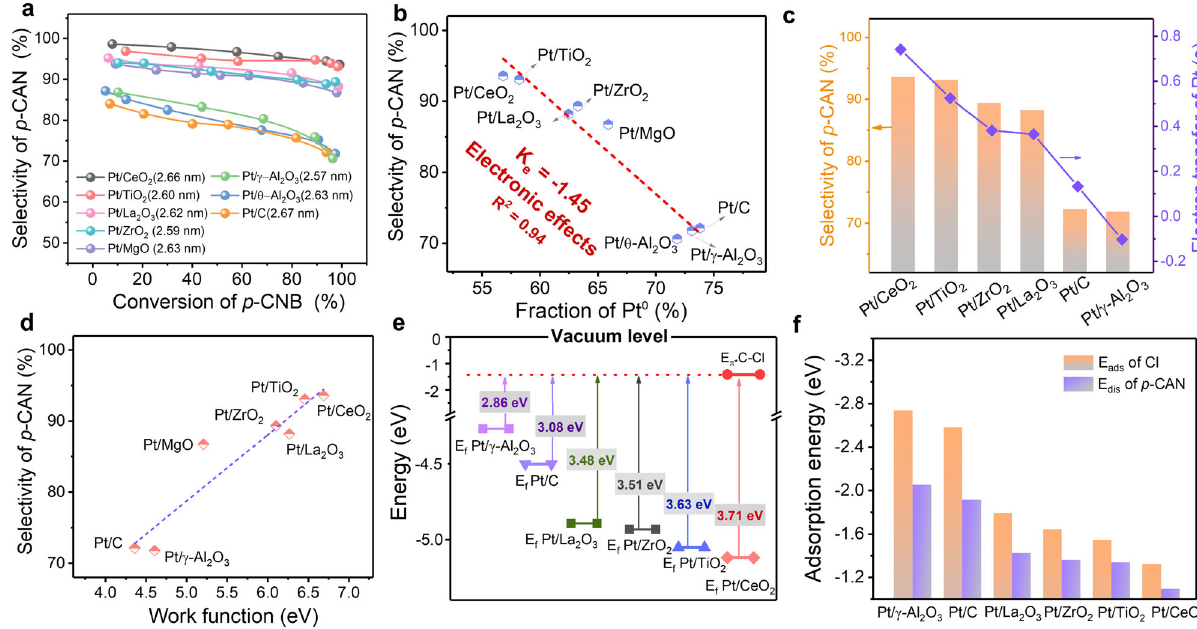
Fig. 3 Correlating the electronic structure of Pt-based catalysts with the catalytic performance in chemoselective hydrogenation of p -CNB. a The selectivity to p -CAN as a function of p -CNB conversion over various catalysts with size-controlled Pt NPs in the size range of 2.6 nm. Reaction conditions: 10 mL toluene, 1 MPa H 2 , 45 °C, 0.5 mmol p -CNB, Pt/ p -CNB: 10 wt ‰ ; b plot of selectivity for p -CAN against the fraction of Pt 0 on different supported Pt catalysts with the similar size range of ~2.6 nm. c Relationship between the selectivity of p -CAN and charge transfer of Pt NPs for the represent Pt models obtained by DFT calculation. d Plot of selectivity for p -CAN against the W f of various supports. e The energy gap between the π * orbital of C – Cl bond and the Fermi levels of the representative Pt 19 -based models, respectively. The values represent Fermi levels against the vacuum. f The dissociation energies ( E dis ) of the p -CAN and the adsorption ( E ads ) energies of Cl on the Pt 19 -based catalyst